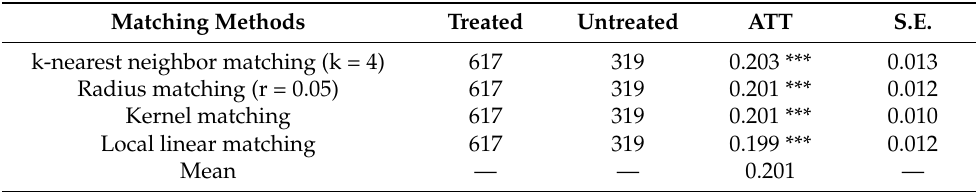
Table 7. Treatment effect of